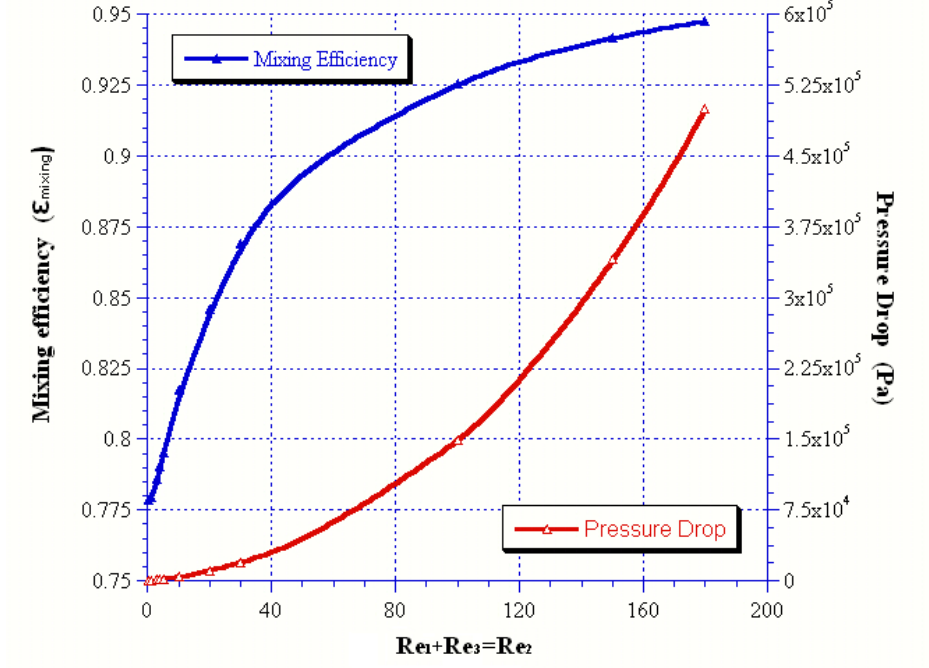
Figure 3. Reynolds number effect versus the mixing and pressure drop at Rer = 1.